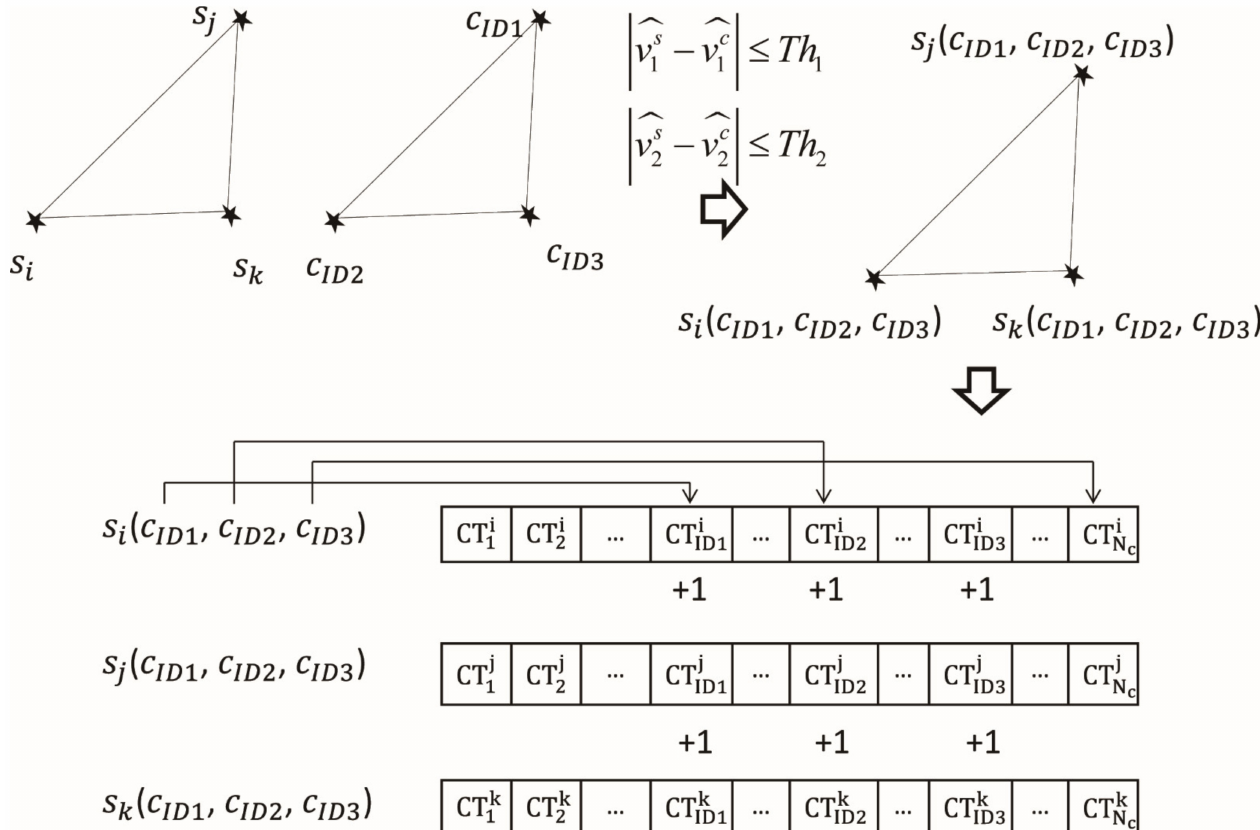
Figure 3. Vote process in the initial match